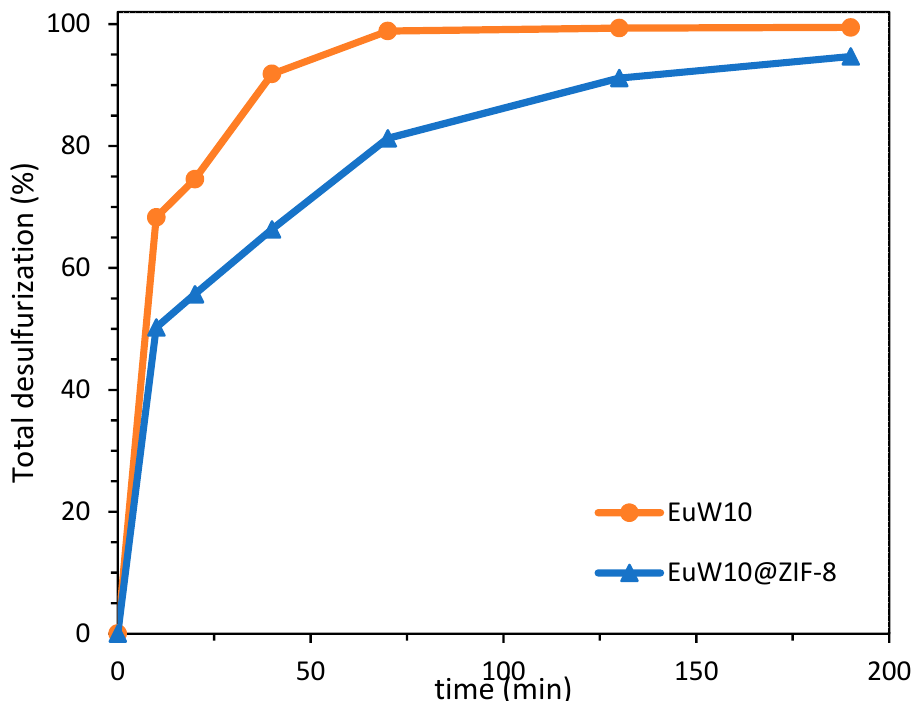
Figure 4. Desulfurization profile of a multicomponent model fuel (DBT, 4-MDBT, 4,6-DMDBT) catalyzed by the heterogeneous EuW 10 @ZIF-8 and the homogeneous EuW 10 (both with 3 μ mol of EuW 10 active center), using [BMIM]PF 6 as extraction solvent and H 2 O 2 as oxidant, at 70 °C.